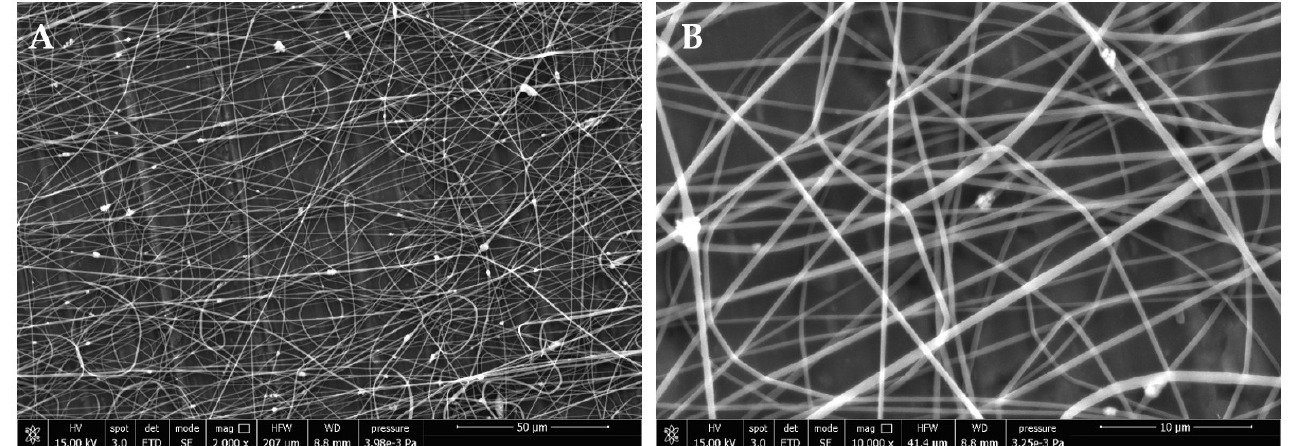
Figure 1. FE-SEM micrographs of the electrospun PVDF nanofiber mesh with dispersed BaTiO 3 nanoparticles. Images were acquired at 15 kV and different magnifications: ( A ) 2000 × (scale bar 50 µ m), and ( B ) 10,000 × (scale bar 10 µ